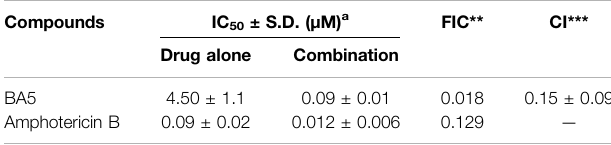
TABLE 2 | Inhibitory concentration for 50% of intracellular parasites forms and selectivity index. Compounds